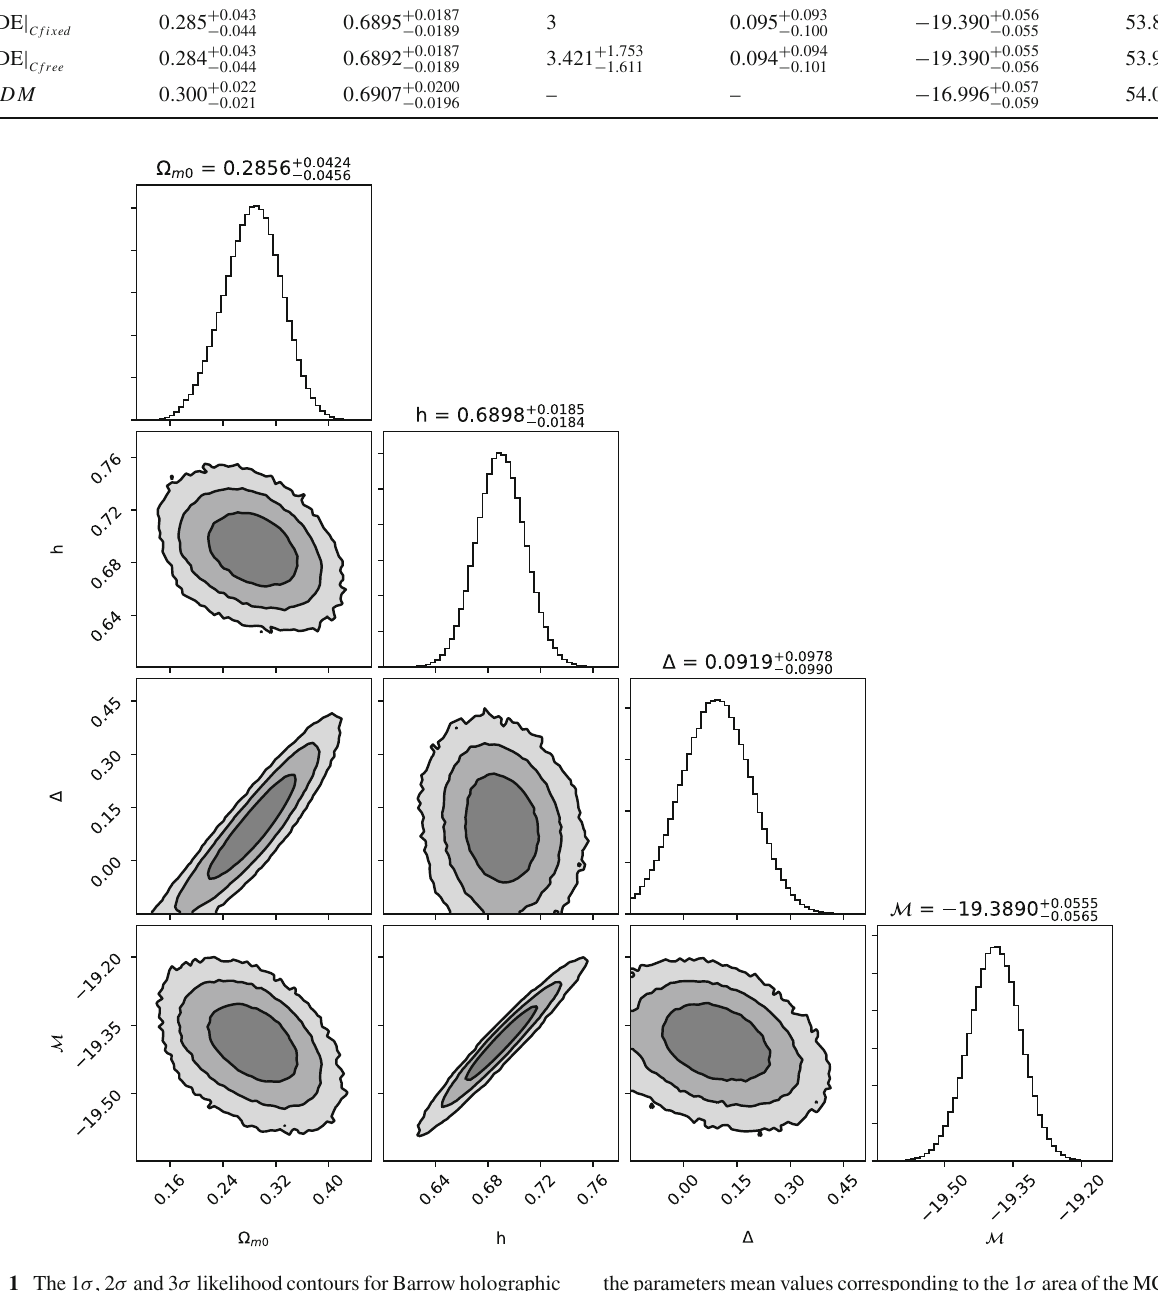
the parameters mean values corresponding to the 1 σ area of the MCMC chain. M is the usual free parameter of SNIa data that quantifies pos- sible astrophysical systematic errors, [75]. For these fittings we obtain χ 2 / dof = 0 . min